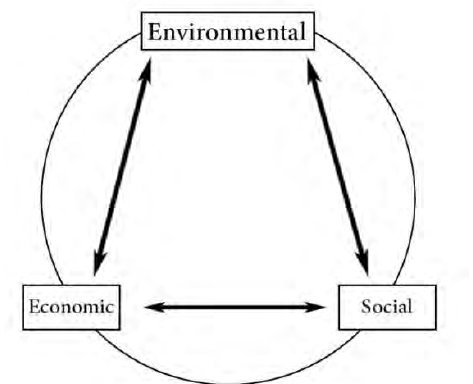
Figure 5. The attributes of sustainability (Source: